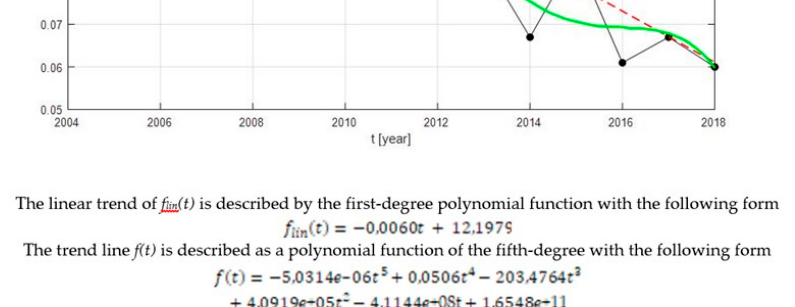
Figure 6. Trends of changes in the frequency of fatal accidents in civil engineering over time.